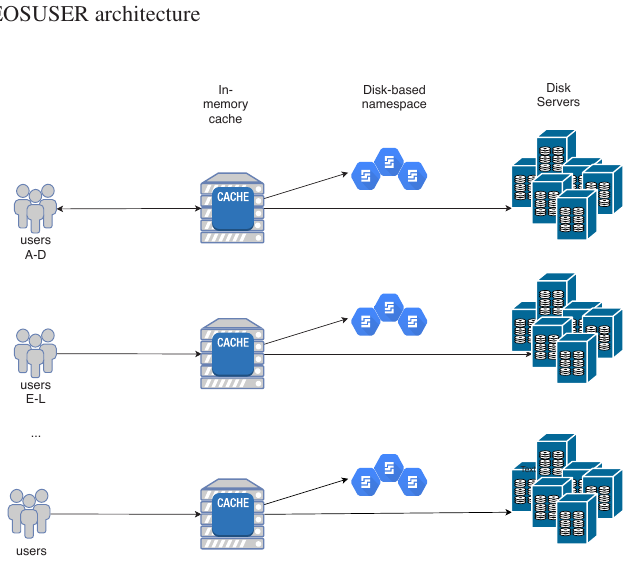
Figure 6. Original EOSUSER architecture